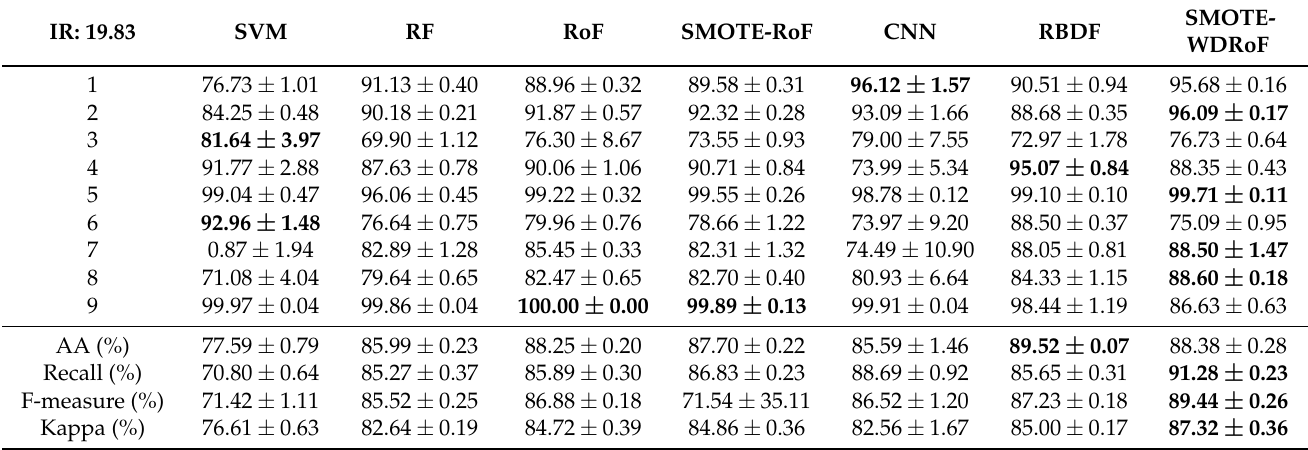
Table 5. Classification results (%) of the University of Pavia ROSIS image, respectively obtained by SVM, RF, RoF, SMOTE- RoF, CNN, RBDF and the proposed SMOTE-WDRoF in the case of the imbalance ratio of 19.83.